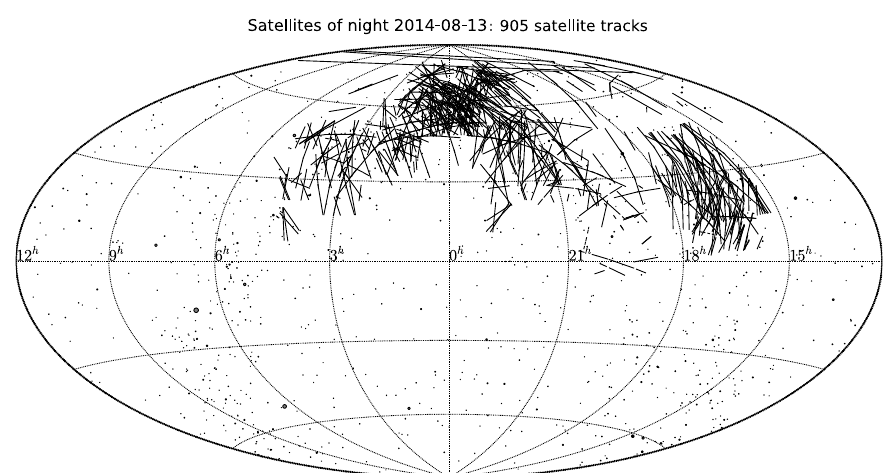
Fig. 7. Satellite trails detected by the MMT on the night of 2014 August 13. Only trajectories with more than 100 detection points are displayed.